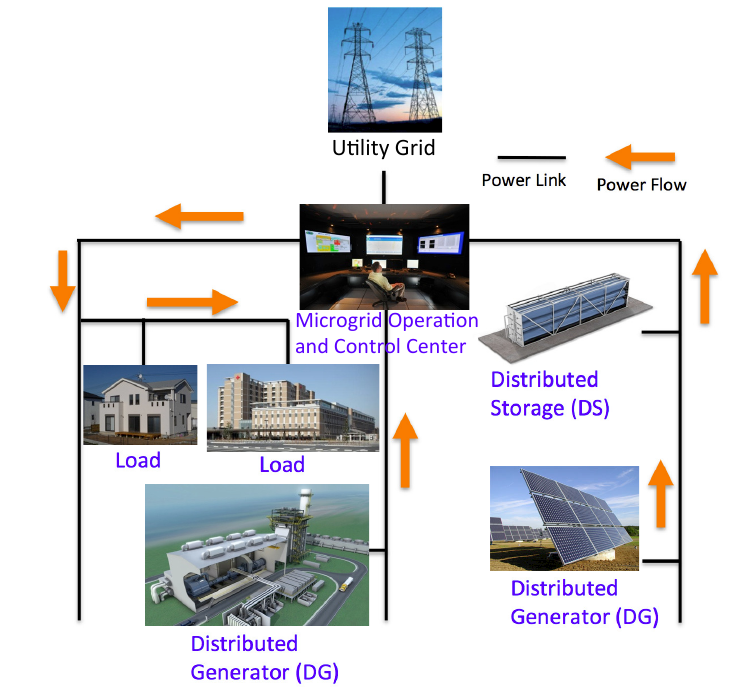
Figure 1. Microgrid configuration